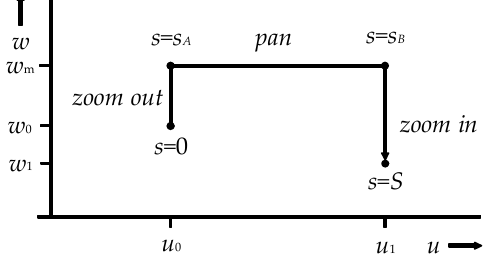
Figure 11. Diagram of the 2D space of panning and zooming (P&Z) reduction, translation, and amplification (adopted from Wijk et al. [25]).